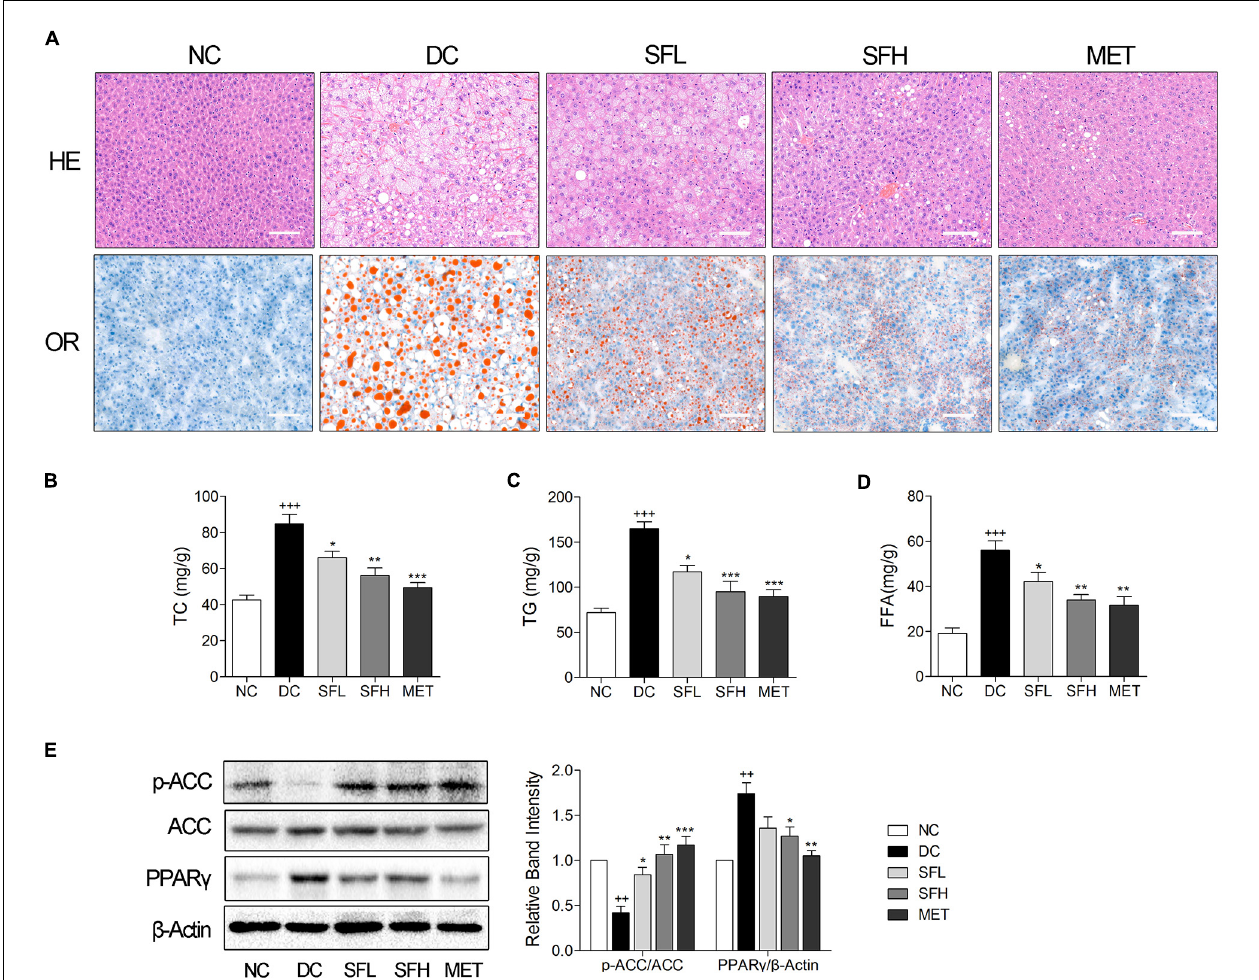
FIGURE 6 | SD-FRE treatment ameliorated hepatic steatosis in KK-Ay mice. (A) HE and OR staining of the liver from KK-Ay mice. Scale bar, 50 µ m. (B–D) The contents of TC, TG, and FFA in the liver from KK-Ay mice. (E) Western blot analysis of ACC phosphorylation and PPAR γ expression in liver. Data are mean ± SEM, shown as relative band intensity compared with NC group ( n = 3). ++ P < 0.01, +++ P < 0.001 vs. NC group, ∗ P < 0.05, ∗∗ P < 0.01, ∗∗∗ P < 0.001 vs. DC